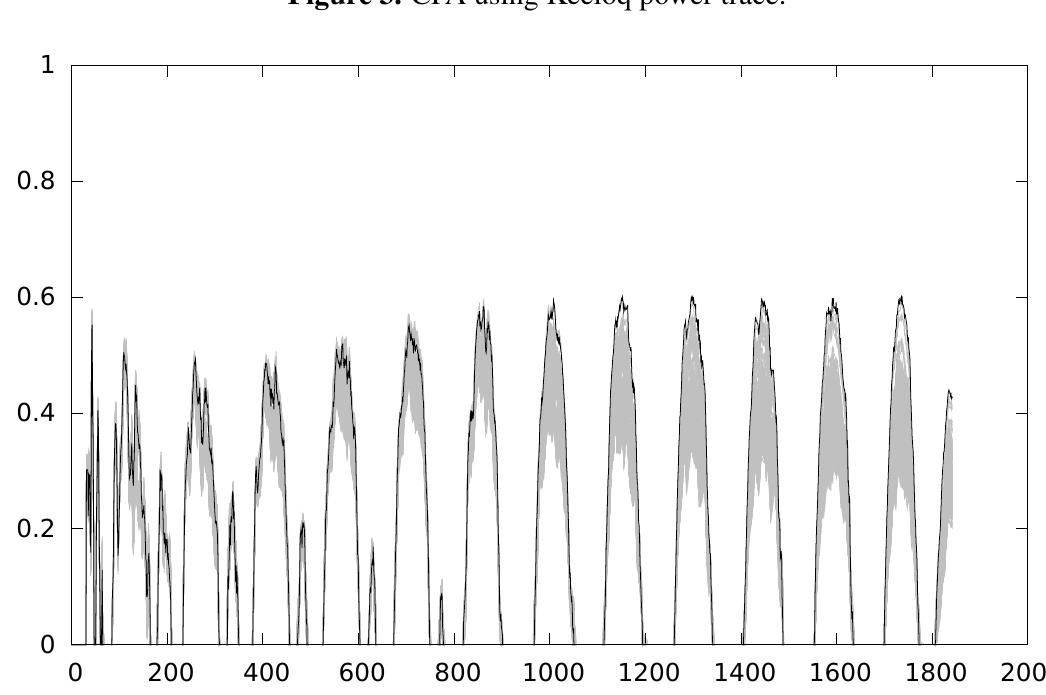
Figure 3. CPA using Keeloq power